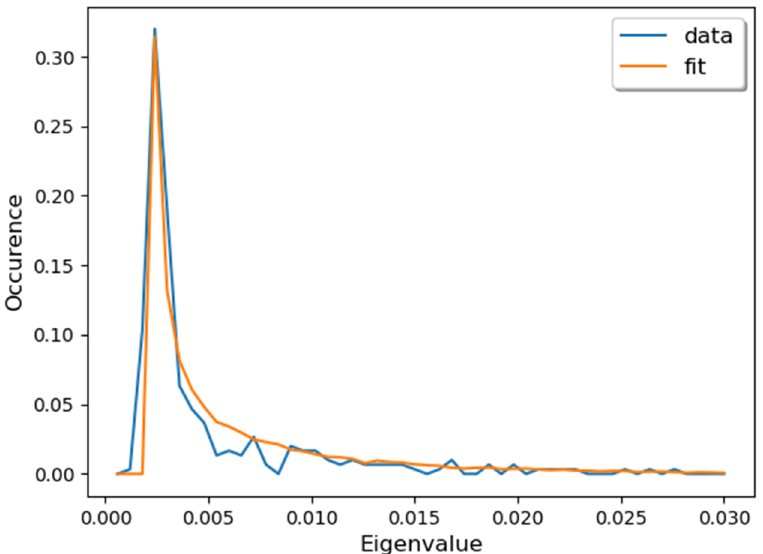
Figure 13. Statistical-model-fitting-generalised gamma distribution over clean pixels used in Visegrad clean mask.